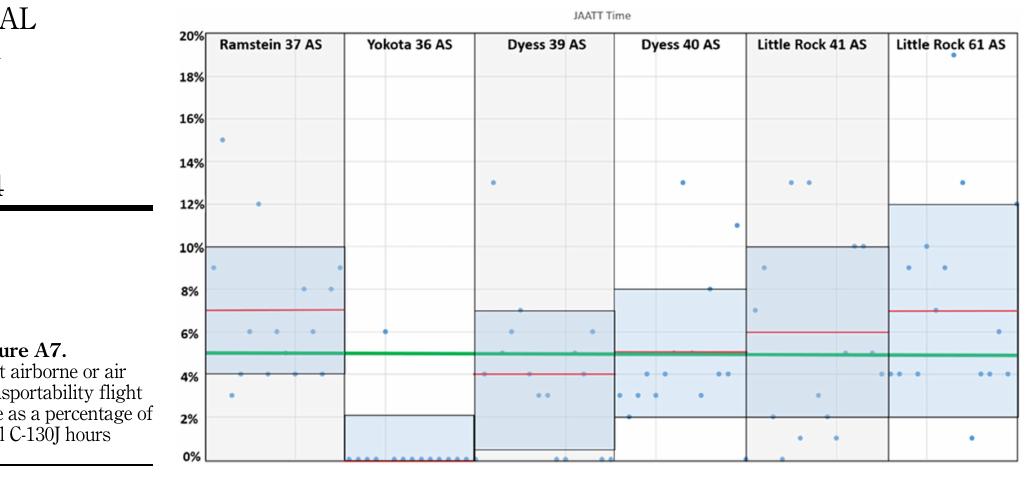
Figure A7. Joint airborne or